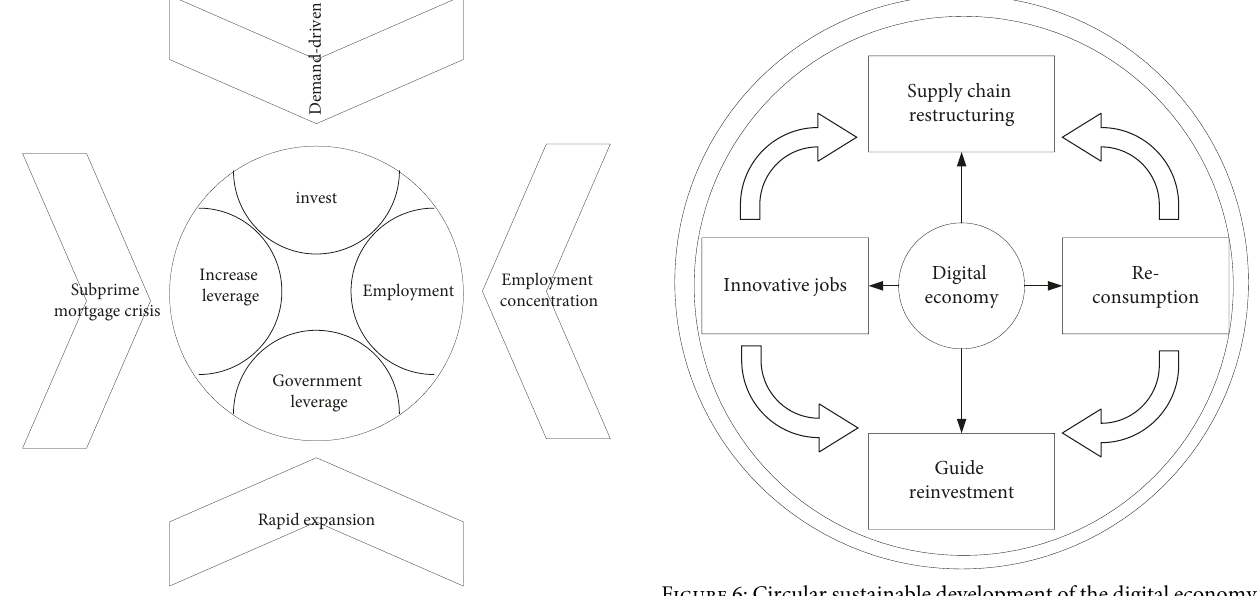
Figure 5: Spiral development of traditional investment